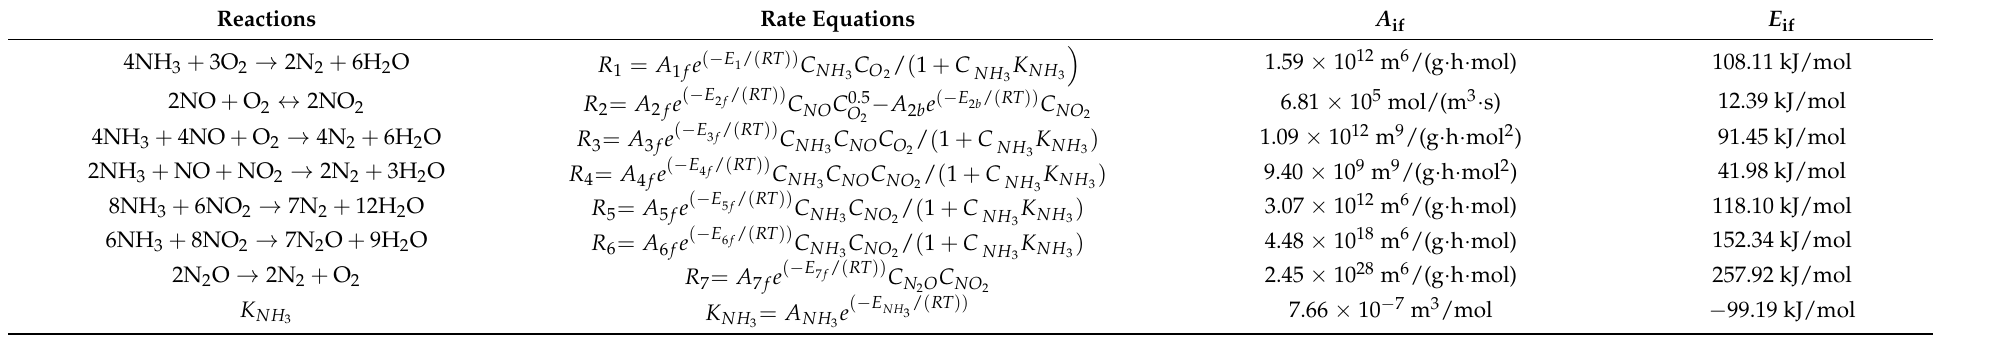
Table 4. Kinetic model without H 2 O in feed gases [25].